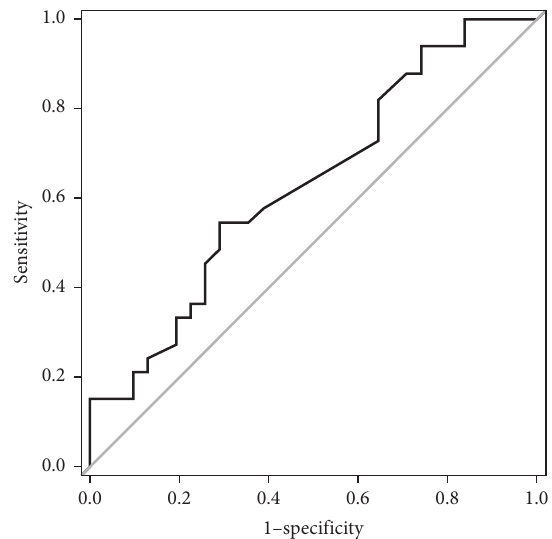
Figure 1: Receiver operating characteristic (ROC) curve of the visual analogue scale (VAS) for PD patients. VAS ranging from 0 to 100% was used to evaluate the subjective olfactory acuity. The ROC curve demonstrates sensitivity (true positive rate) and 1 − spec- ificity (false positive rate) of the VAS according to an objective diagnosis of hyposmia or